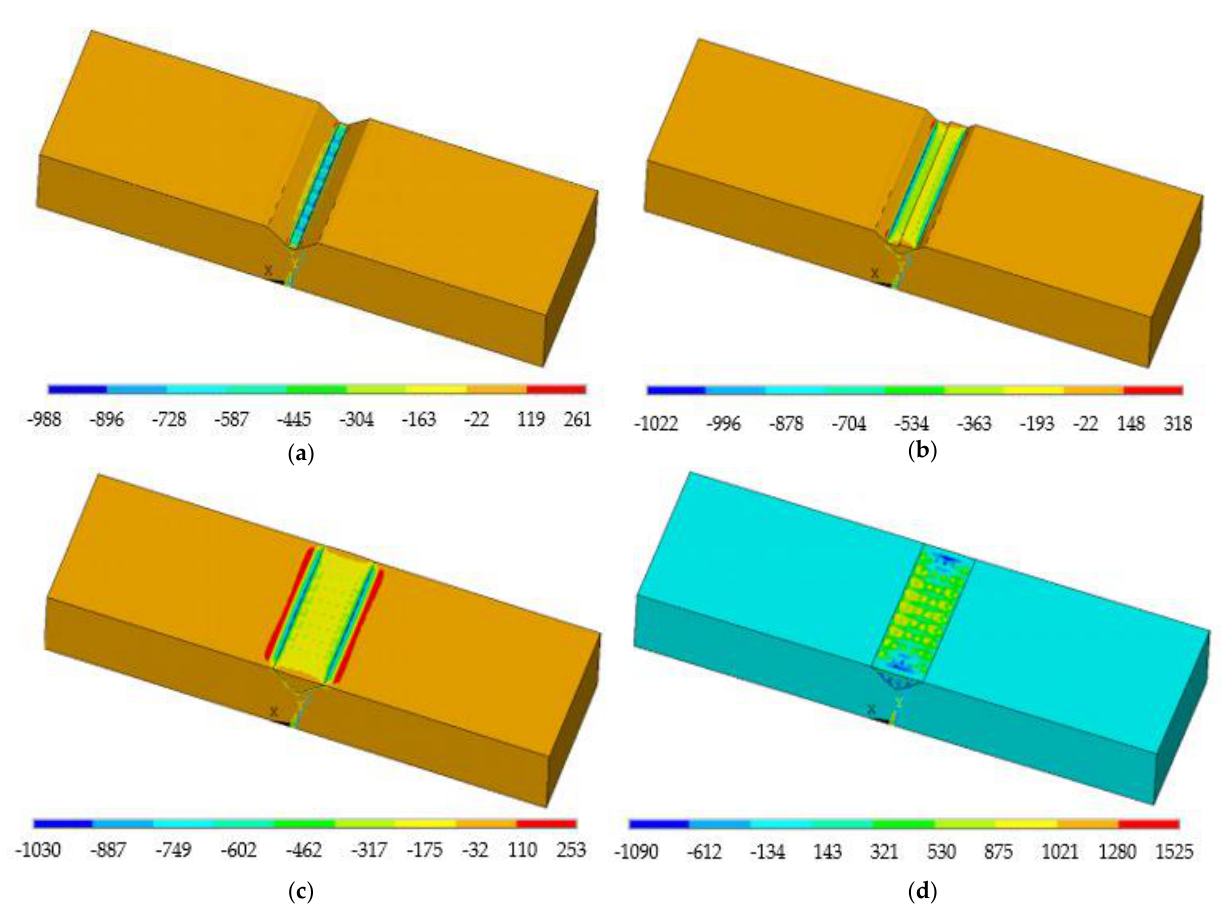
Figure 10. Longitudinal stress distribution at the end of the 1st ( a ), 4th ( b ), and final ( c ) tracks, and after cooling to room temperature ( d ).